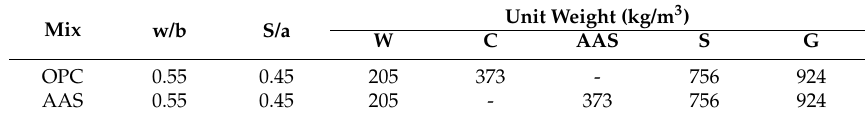
Table 3. Variables for mechanical tests.